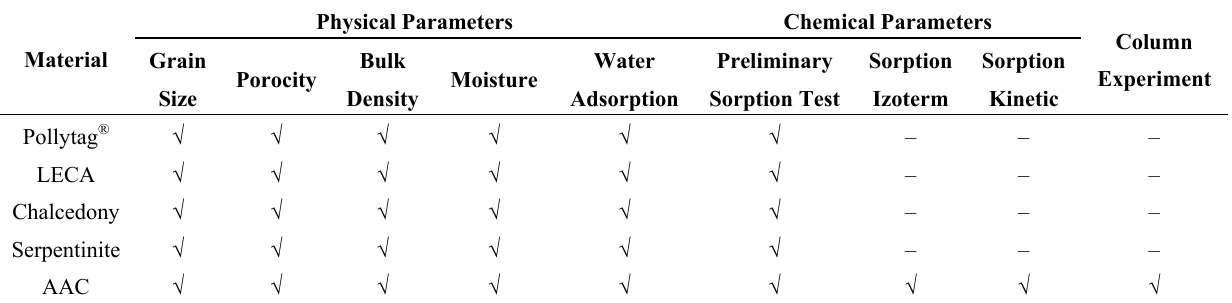
Table 4. Summary table of performed